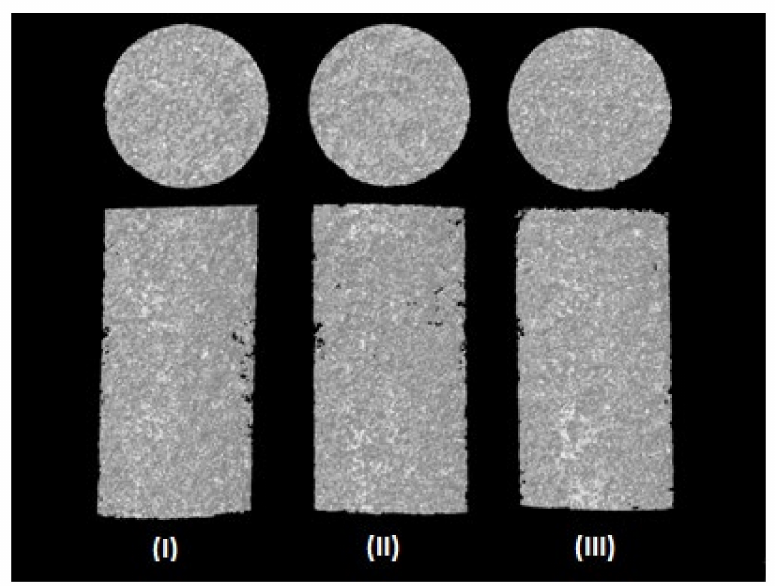
Figure 5. Representative three-dimensional (3D) images of the porous PEVAL/PDVAL blend ( I ), and the PEVAL/PDVAL/ β -TCP50 ( II ) and PEVAL/PDVAL/ β -TCP70 ( III ) hybrid materials.